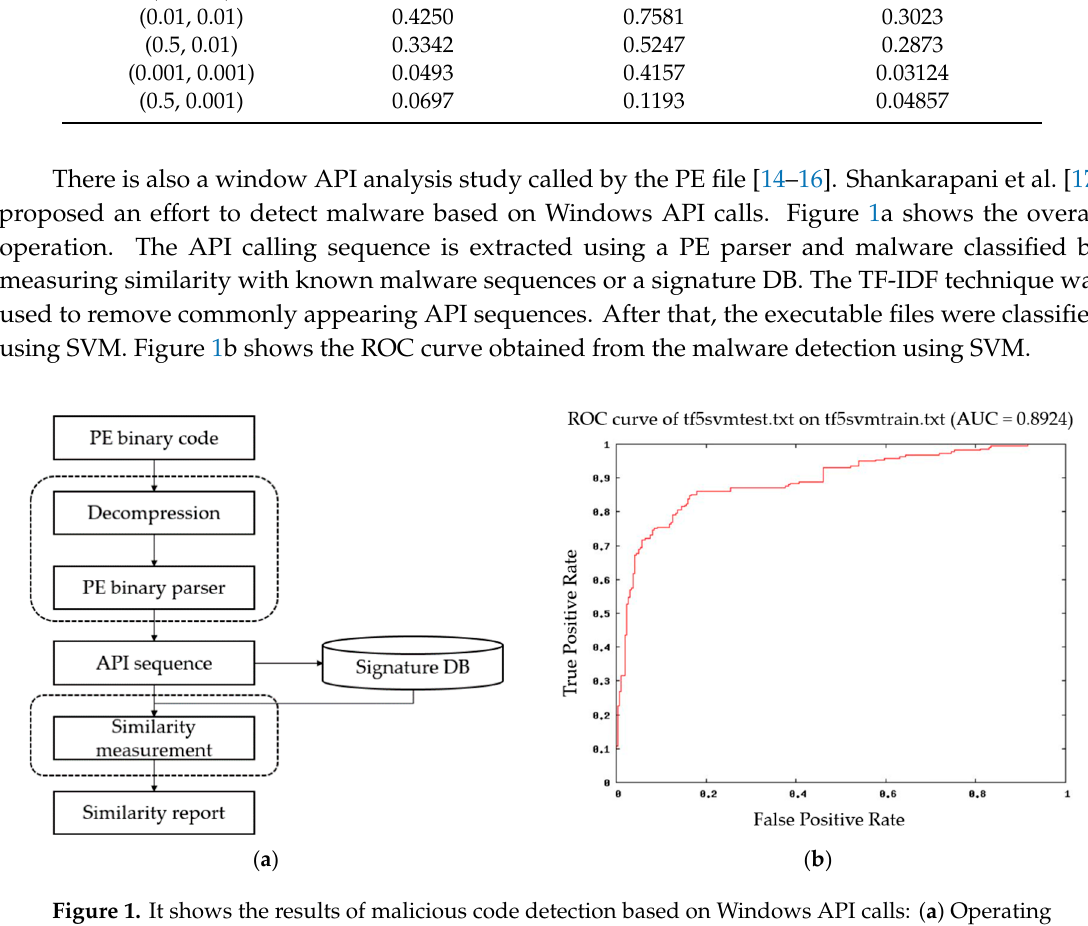
Figure 1. It shows the results of malicious code detection based on Windows API calls: ( a ) Operating process; ( b ) ROC curve obtained from malware detection using SVM.